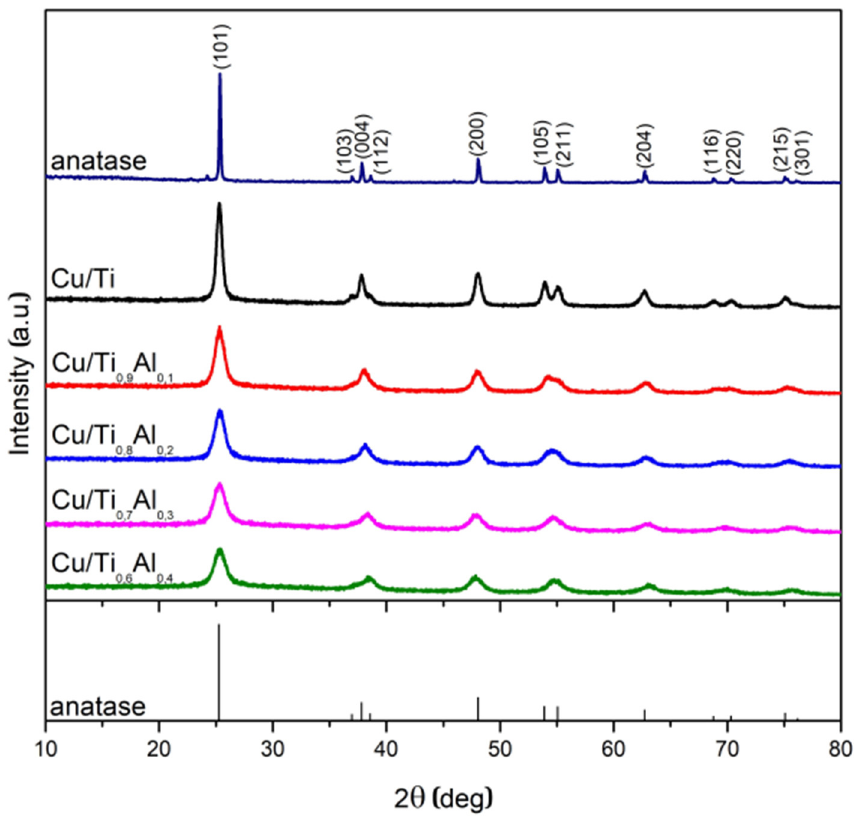
Figure 1. XRD patterns of Cu/Ti x Al 1-x catalysts and the reference—commercial TiO 2 anatase com- pared with data [01-071-1167].